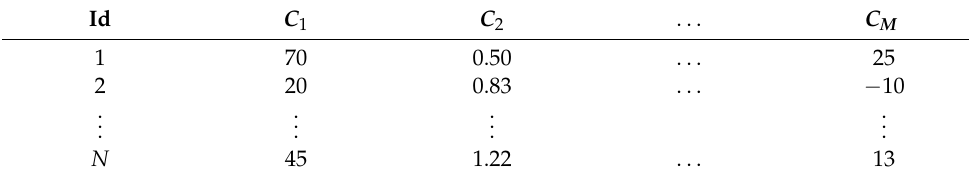
Table 2. Representation of a set of students.